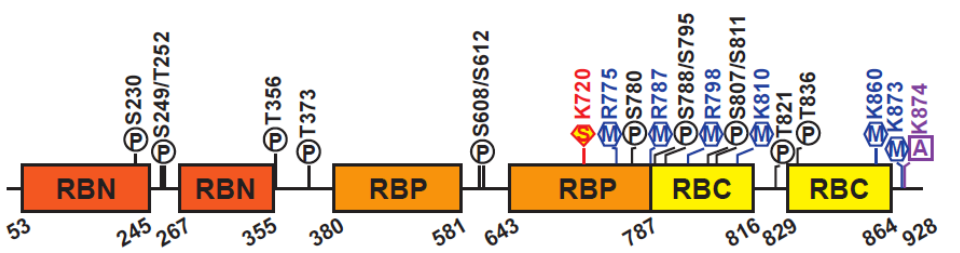
Figure 2. Schematic of pRB structure. Representation of the human pRB domain organization and post-translational modifications. Structured domains are depicted as colored boxes, unstructured domains are depicted as a line in black. Phosphorylation (P) sites are shown in black, methylation (M) sites in blue, acetylation (A) sites in purple, and sumoylation (S) sites in red.